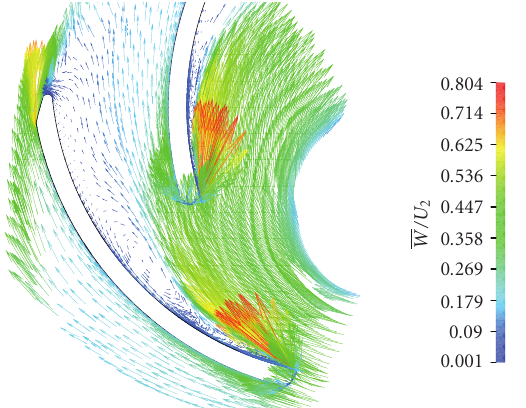
Figure 5: Pressure fluctuation in the impeller at midspan Q des .